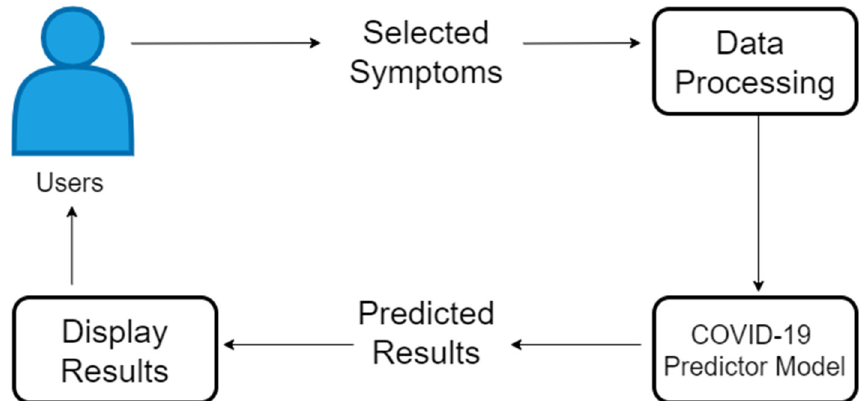
Figure 7. The workflow of the developed web-based application.